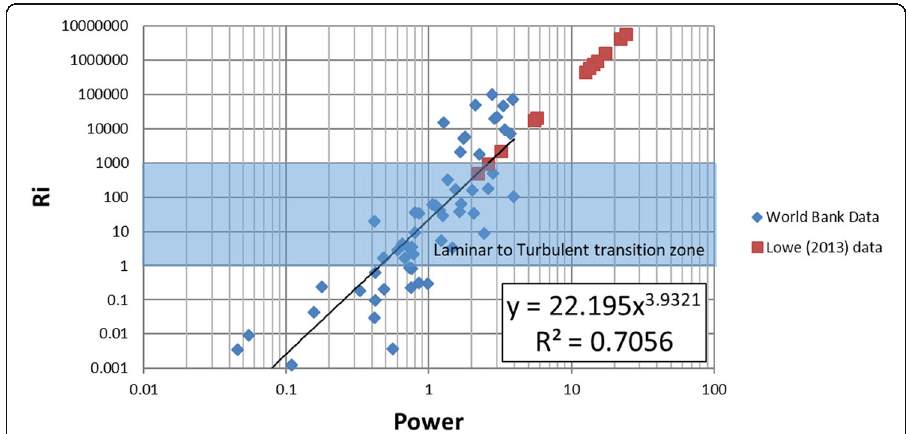
Fig. 24 Estimating the state of innovation using only an organisation ’ s RnD expenses